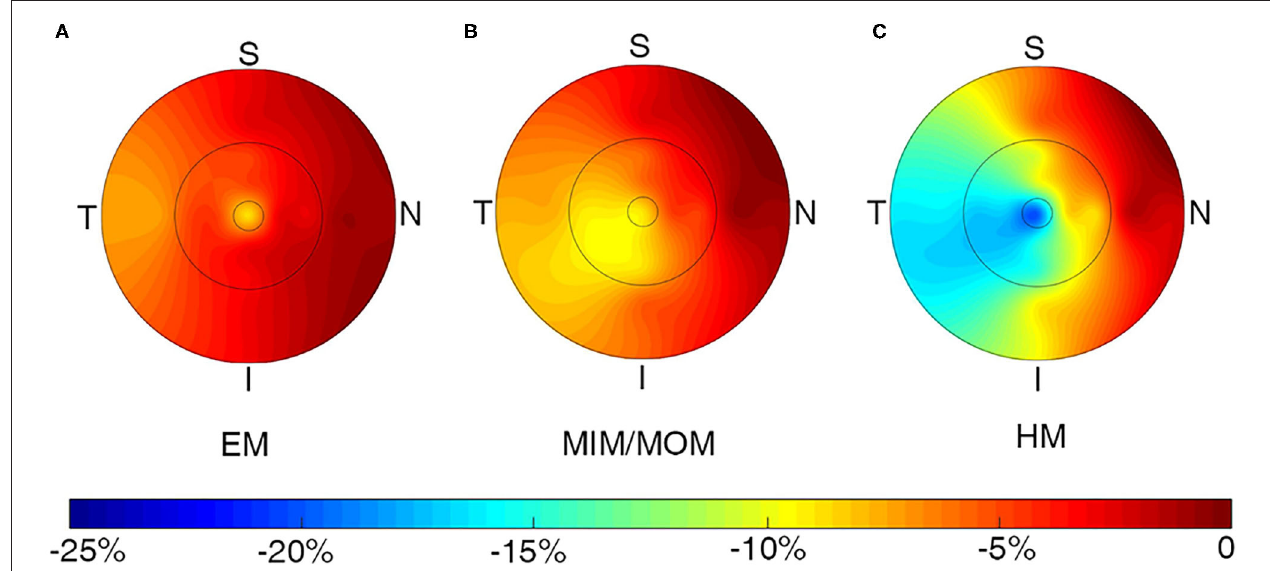
FIGURE 3 | Topographic variation of the change rate of macular vessel density in all sectors for (A) EM, (B) MIM/MOM, (C) HM. EM, emmetropia; HM, high myopia; MIM/MOM, mild-to-moderate myopia.